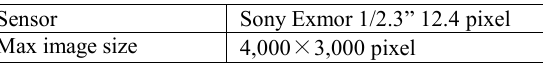
Table 2. UAV camera specification